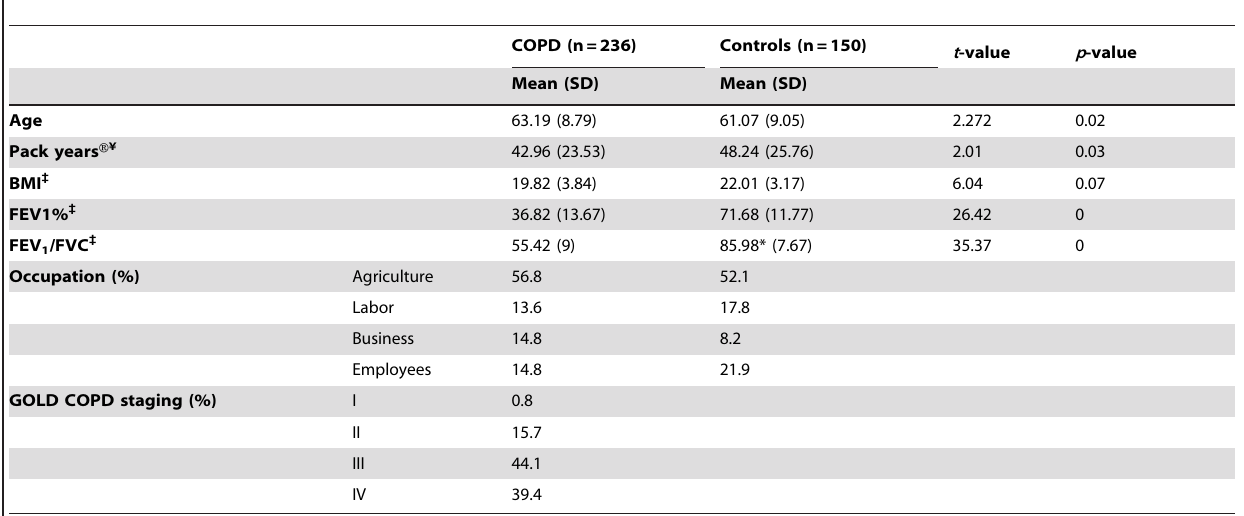
H p - value adjusted for age. ` p-value adjusted for age and pack years.